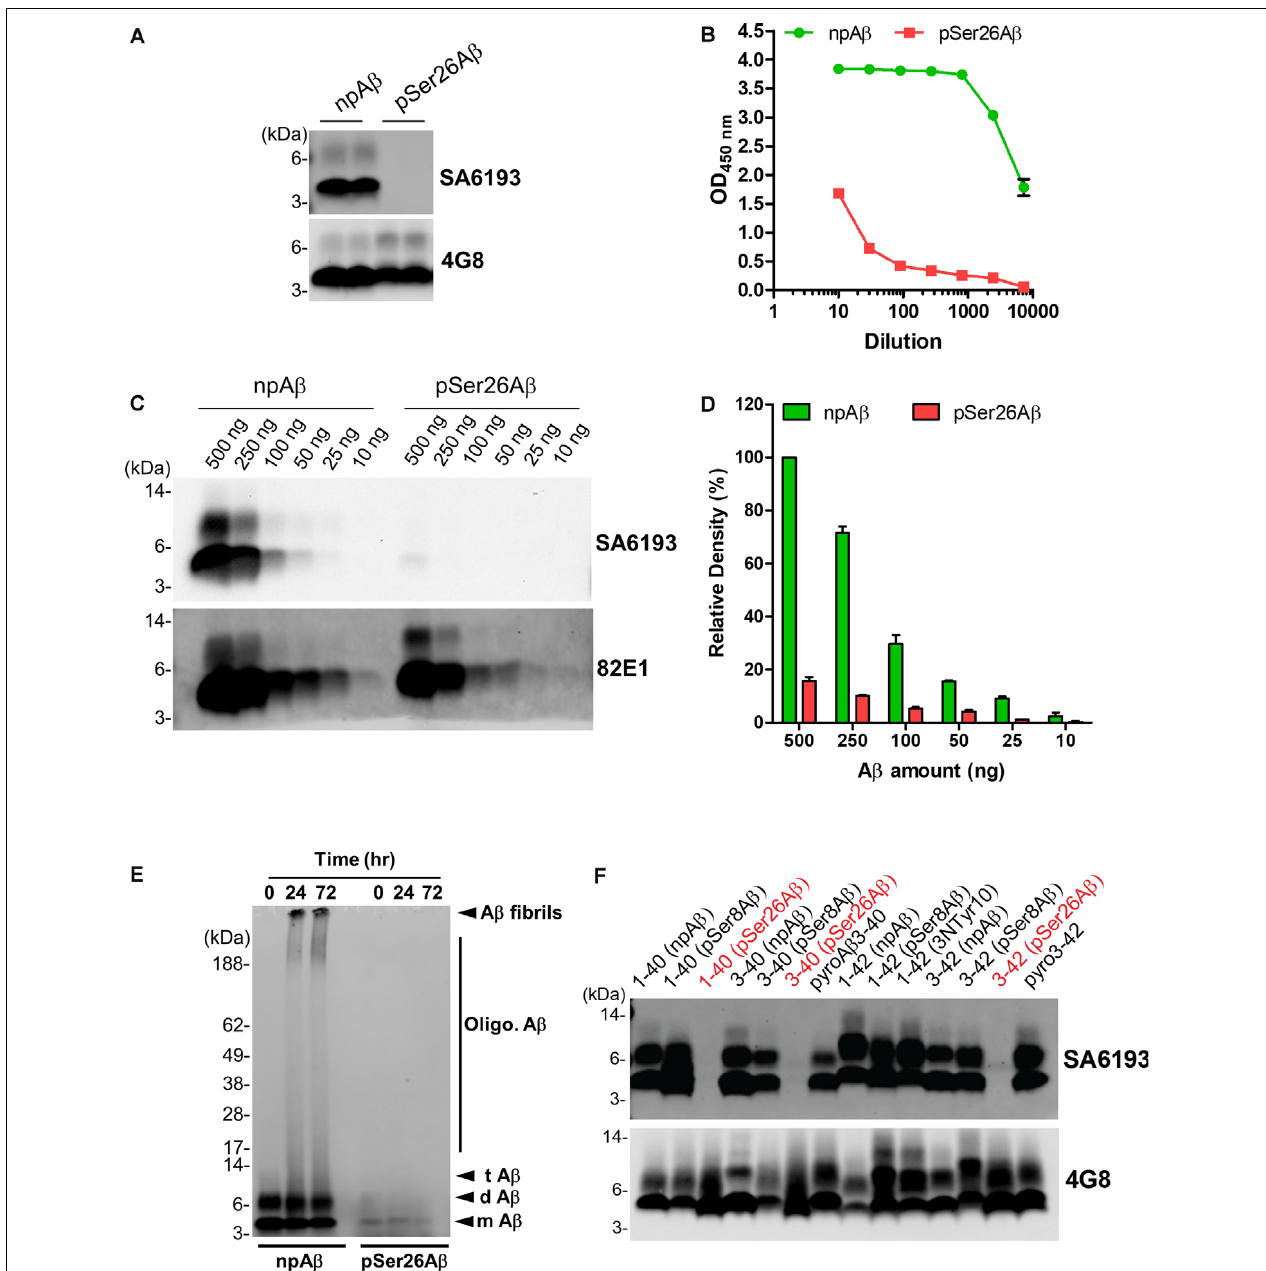
FIGURE 3 | Characterization of the non-phosphorylated Ser26A β specific polyclonal SA6193 antibody. (A) WB analysis of synthetic npA β and pSer26A β peptides (200 ng) with rabbit sera shows the specific detection of npA β by SA6193 rabbit polyclonal antibody. Reprobing of the blot with generic 82E1 antibody shows the presence of both npA β and pSer26A β variants. (B) Purified SA6193 antibody binding assessed by serial dilution of antibody on ELISA plates that were coated with npA β and pSer26A β antigen. (C) WB analysis of different quantities of npA β and pSer26A β peptides with SA6193 antibody or 82E1 antibody. The SA6193 antibody selectively recognizes npA β monomers and dimers. SA6193 antibody selectively detects npA β as low as 25 ng in WB (C) and ELISA ( Supplementary Figure 2B ). The membrane immunoprobed with 82E1 antibody shows the presence of both A β variants. (D) Densitometry quantification of the SA6193 antibody shows the reactivity against various quantities of the npA β peptide. Values indicate mean ± SD ( n = 3). (E) Preparations of unaggregated (0 h) and aggregated (24 and 72 h) npA β and pSer26A β peptides were electrophoresed and immunoblotted with SA6193 antibody. The SA6193 antibody specifically detects npA β in both unaggregated and aggregated state ( Supplementary Figure 4 ). m A β -monomeric A β ; d A β -dimeric A β ; t A β -trimeric A β ; Oligo. A β -Oligomeric A β (F) Variety of non-modified, truncated, and post-translationally modified A β 40 and A β 42 variants were electrophoresed and immunoblotted with SA6193 antibody. SA6193 antibody does not cross-react with A β variants that are phosphorylated at Ser26 residue but detects all of the tested non-modified (A β 1–40 or A β 1–42), truncated (A β 3–40 or A β 3–42) and modified A β 40 and A β 42 variants that carry other PTMs in their N-terminal regions, including phosphorylated Ser8-A β , nitrated and pyroglutamate A β ( Supplementary Figure 3